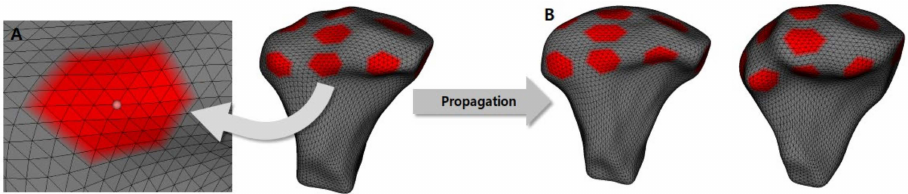
Figure 5. ( A ), 37 points per area for the mesh statistics; ( B ), examples of mesh propagation. All condyle models utilized the same area for the mesh